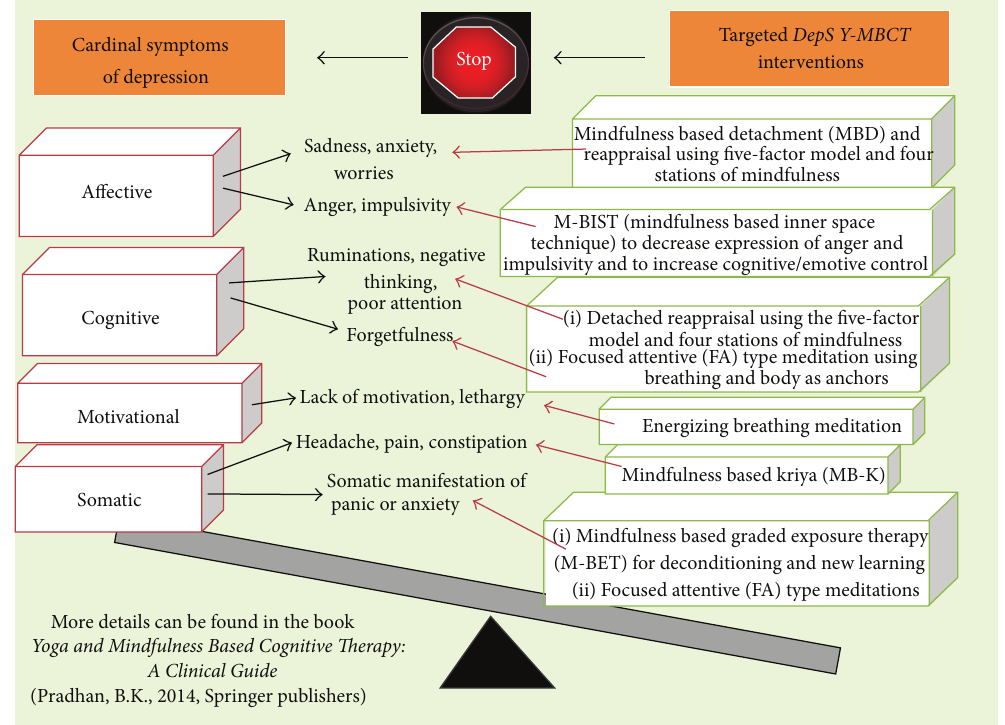
Figure 1: Depression specific Yoga and mindfulness based cognitive therapy ( DepS Y-MBCT )